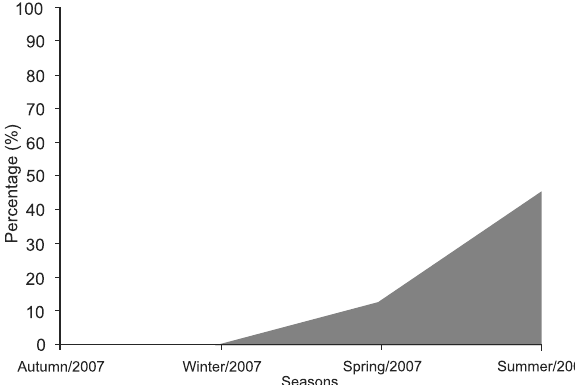
Figure 6. Percentage of ovigerous females of Callinectes ornatus caught during the study period in the Estuary-Bay Complex of São Vicente, by